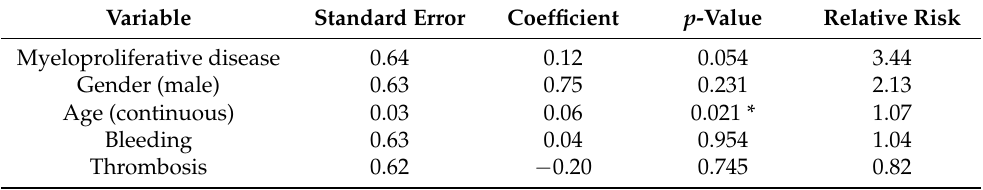
Table 6. Multivariate Cox regression analysis of mortality: model B. Patients with BCS, n = 46. Variable Standard Error Coefficient p -Value Relative Risk Myeloproliferative disease 0.64